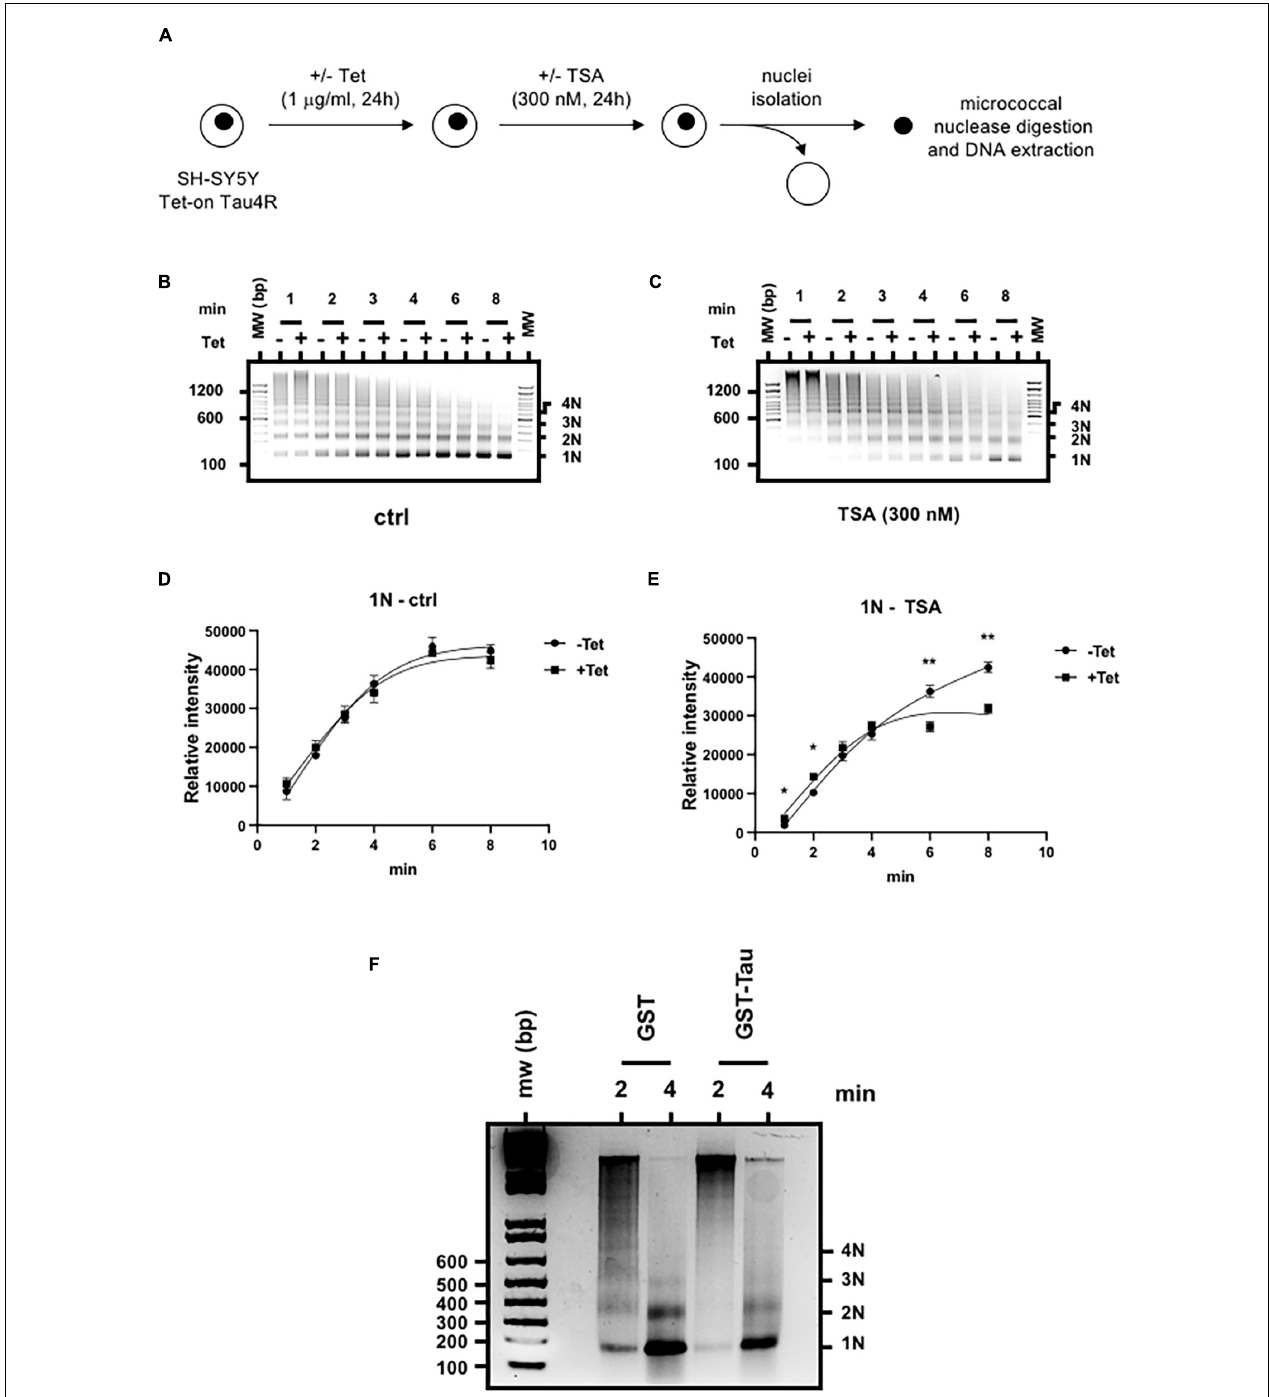
FIGURE 7 | Tau4R increases chromatin compaction. (A) Schematic representation of the experimental procedure. Nucleosome ladders obtained after micrococcal nuclease digestion of SH-SY5Y Tet-on Tau4R cells treated or not with tetracycline (Tet, 1 µ g/ml, 24 h) then followed (B) or not (C) by TSA treatment (300 nM, 24 h). Digested chromatin was analyzed on a 1.5% agarose gel and revealed by ethidium bromide staining. Mono-, di-, tri, and tetra-nucleosomes are indicated on the right. One representative experiment out of three is shown. (D,E) Densitometric analysis of the 1N fragments obtained in control (B) and TSA-treated conditions (C) were calculated from three independent experiments. Data are mean ± SD,* P < 0.05, ** P < 0.01. (F) Tau4R reduces chromatin template accessibility to micrococcal nuclease in vitro . Reconstituted nucleosomal arrays were incubated with 3 µ g of GST or GST-Tau4R and subjected to micrococcal nuclease digestion for 2 or 4 min. Purified DNA fragments were then run on a 1.5% agarose gel in 0.5 × TBE buffer and revealed by ethidium bromide staining. Mono-, di-, tri, and tetra-nucleosomes are indicated on the right. One representative experiment out of three is shown.